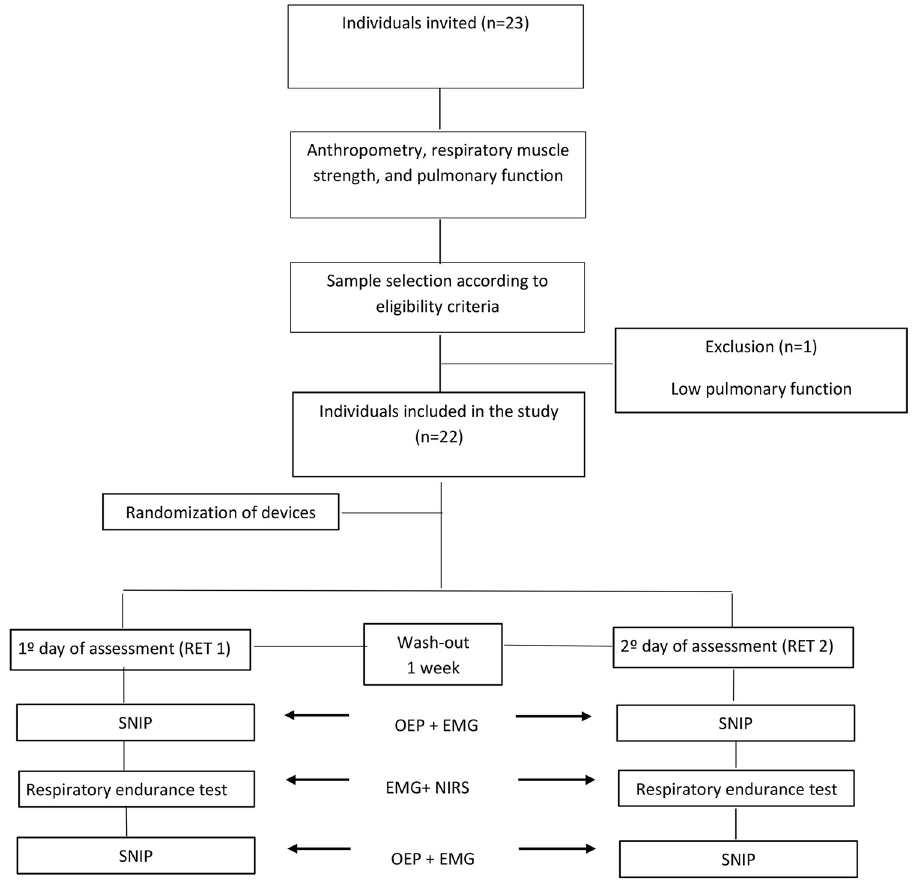
Fig 1. Flowchart of participant